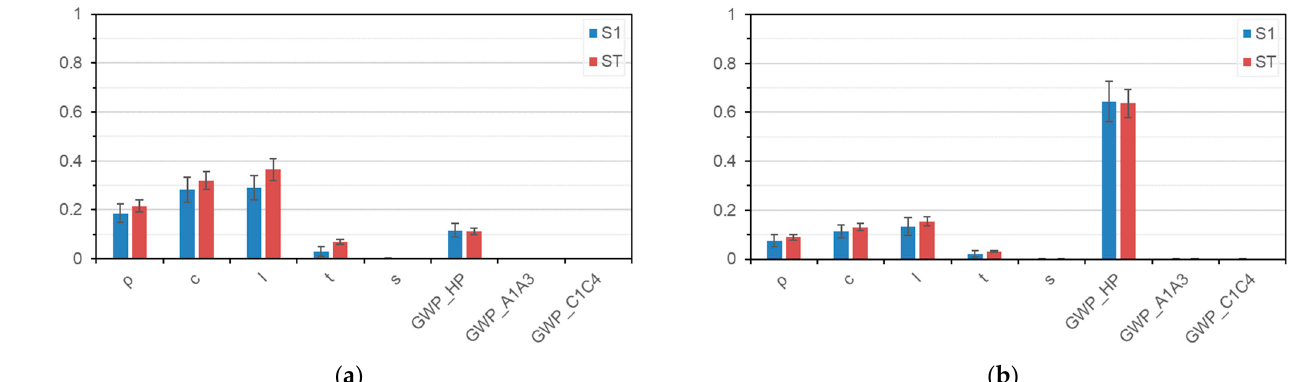
Figure 14. First-order (S 1 ) and total-order (S T ) sensitivity indexes for the total GWP impacts for: ( a ) A-S1; ( b ) A-S2. Error bars represent the indexes’ confidence intervals (with a confidence level of 95%).